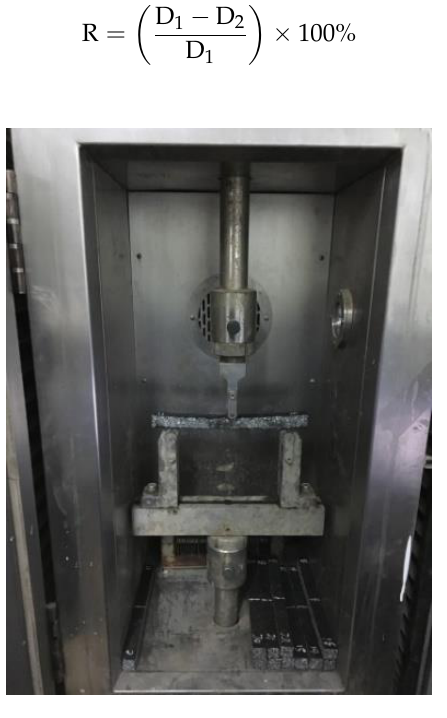
Figure2. The testing equipment of the deformation recovery test. Figure 2. The testing equipment of the deformation recovery